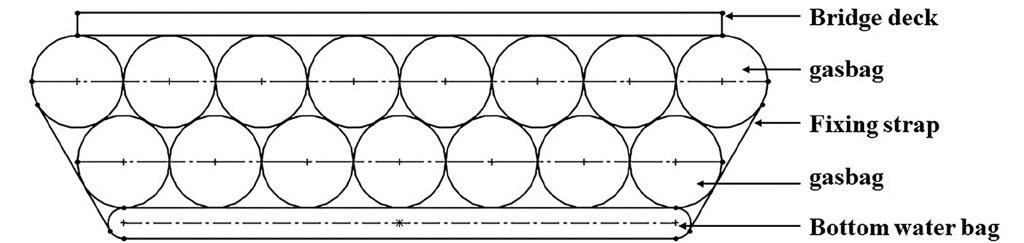
Figure 12. Equipment schematic.